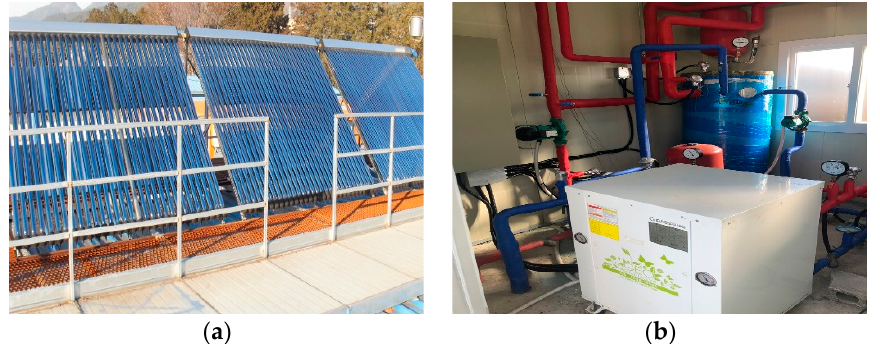
Figure 2. Heating systems used in the experiment. ( a ) Evacuated tube collector. ( b ) Geothermal heat pump system with circulating pipes and water storage tank. pump system with circulating pipes and water storage